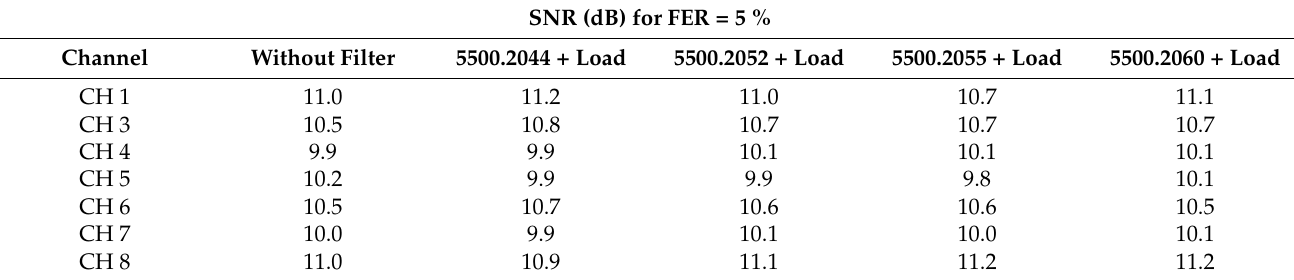
Table 8. SNR required for FER = 5 % in each signal configuration when filters are Table 7. SNR required for FER = 5% in each signal configuration when filters are not loaded.